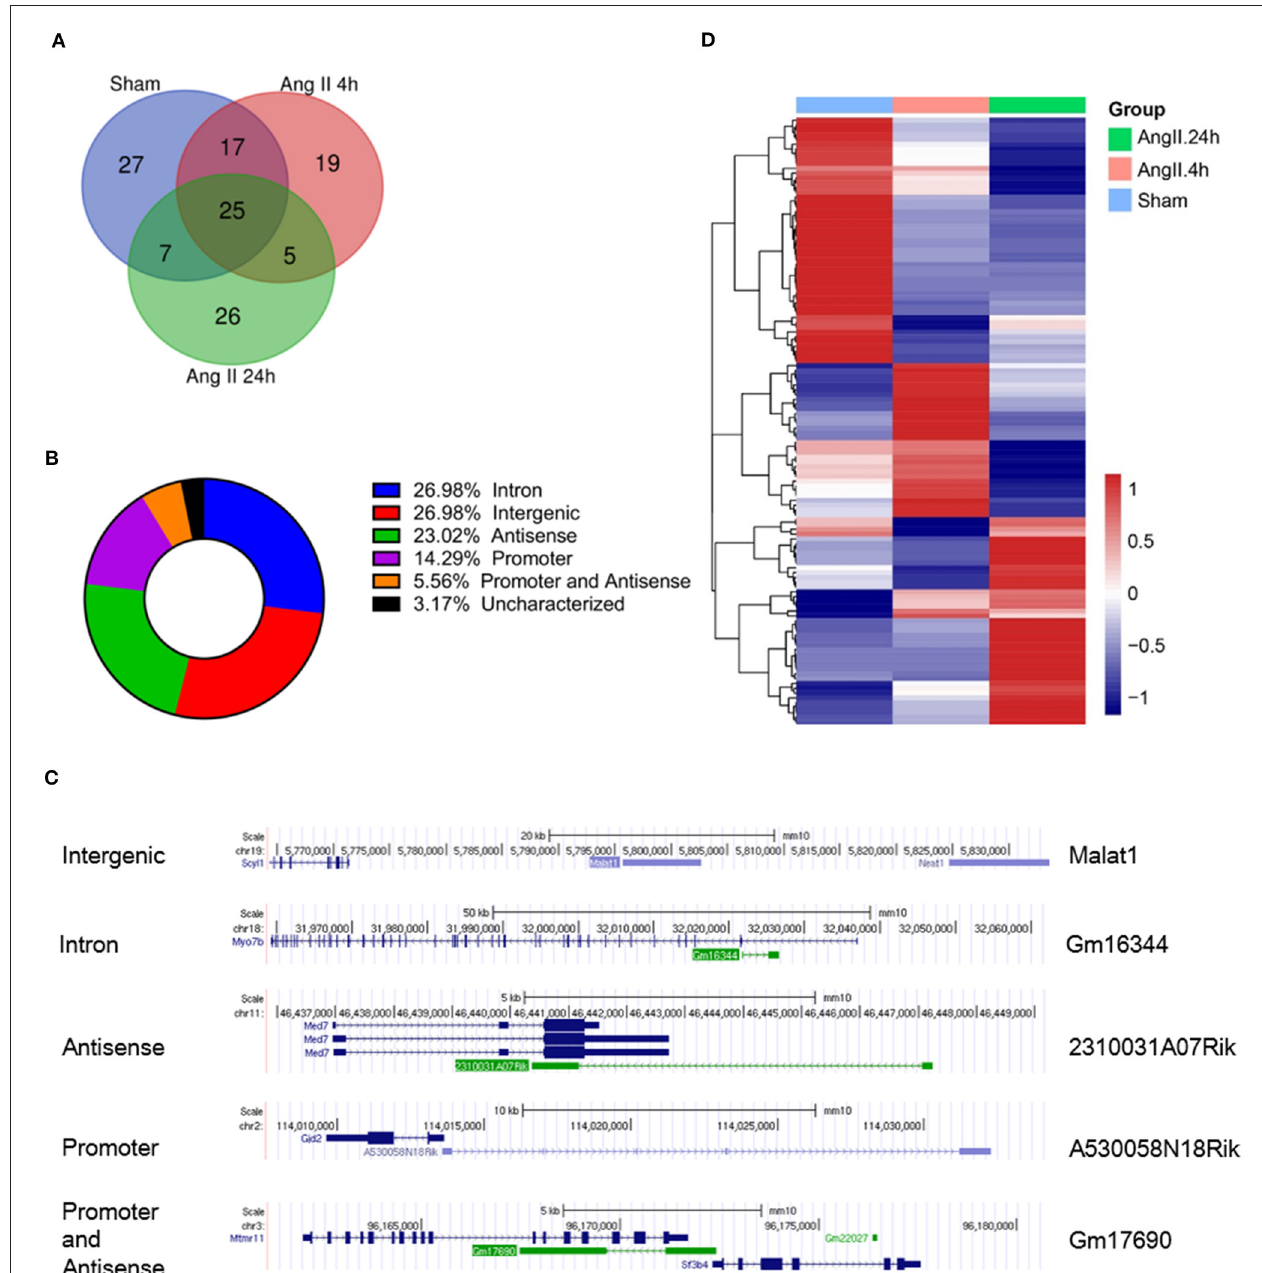
FIGURE 2 | Profiles of EZH2-binding ncRNAs in mouse hearts treated with AngII at different time points. (A) Venn diagram showing the number of overlapped ncRNAs from three groups as indicated. (B) Pie chart showing the distribution of ncRNA categories according to their genomic features. (C) Representative ncRNA for each category. (D) Heat map showing hierarchical clustering of changed EZH2-associated ncRNAs after AngII treatment at different time points. Up-regulated and down-regulated genes are colored in blue and yellow, respectively.